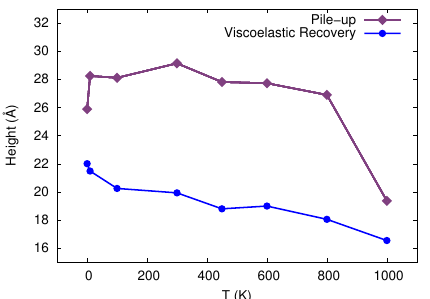
Figure 4. Pile-up height and viscoelastic recovery as a function of temperature. Both quantities are measured after removal of the indenter.